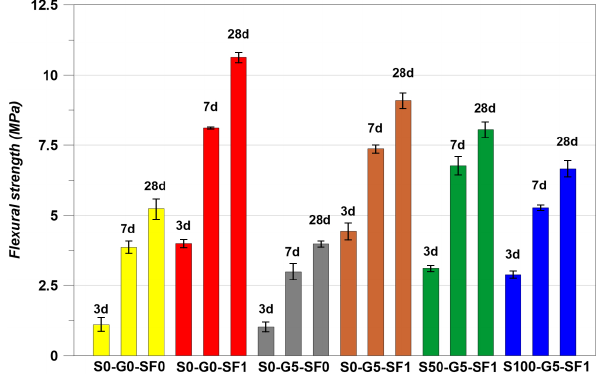
Figure 10. Flexural strength results.